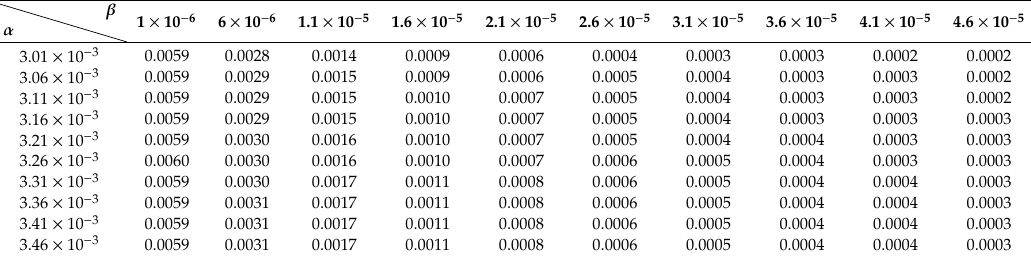
Table 5. False Killer Whale with di ff erent α , β corresponding to SNR Table 4. SNR changes before and after ACMD optimization.